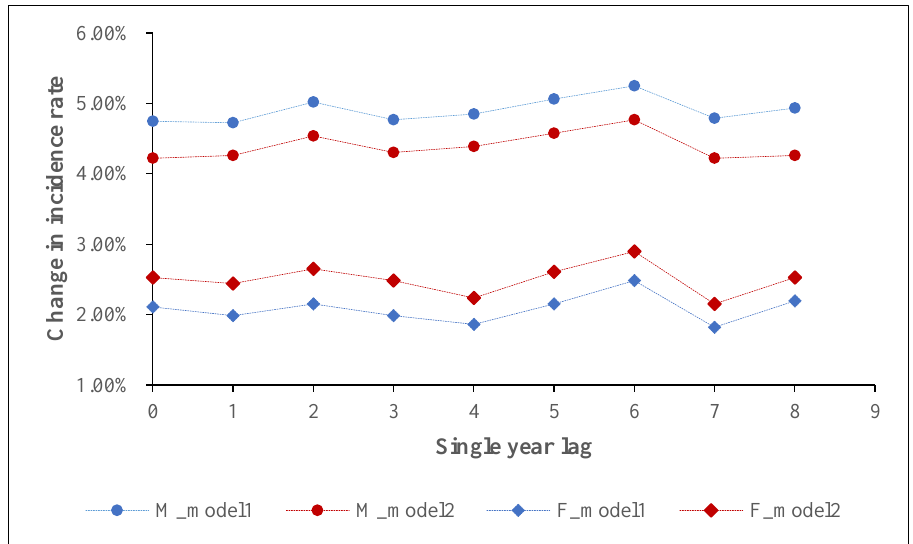
Figure 3. Association between PM2.5 and the incidence rates of lung cancer using different single year lags.